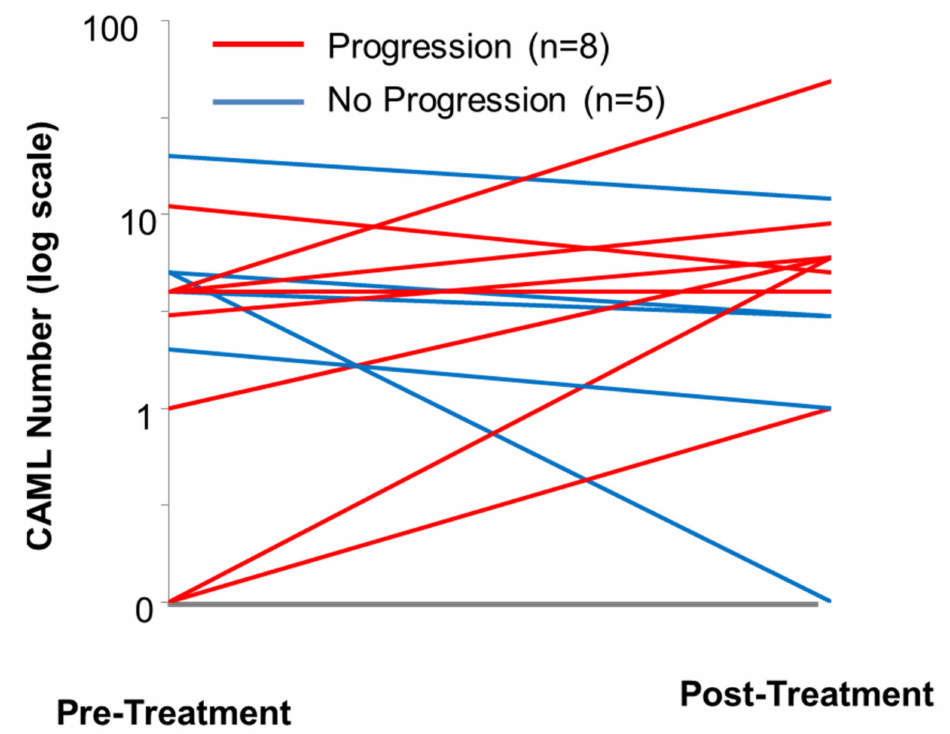
Figure 15. CAML enumeration in patients who had pancreatic surgery to determine whether the patients will likely progress within 2 years versus CAML enumeration in patients who did not progress. Blood was collected at pre-treatment and post-treatment time points. Among patients who experienced progression during treatment (red lines), six patients presented an increase in CAML number, one patient showed equal numbers, and one a decrease in CAML number from 11 to 5 CAMLs. All five patients who experienced no progression during treatment (blue lines) presented a decrease in CAML